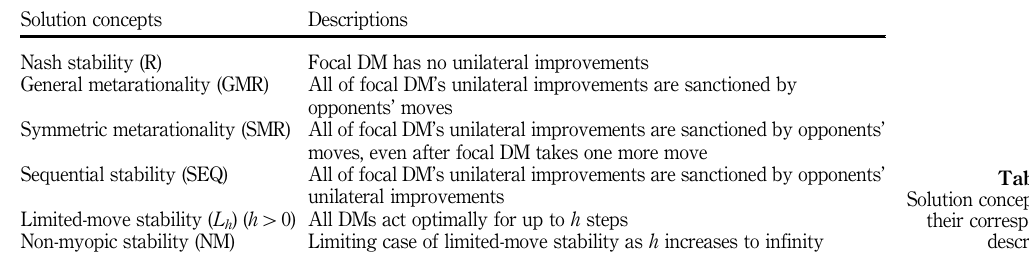
Table IV. Solution concepts